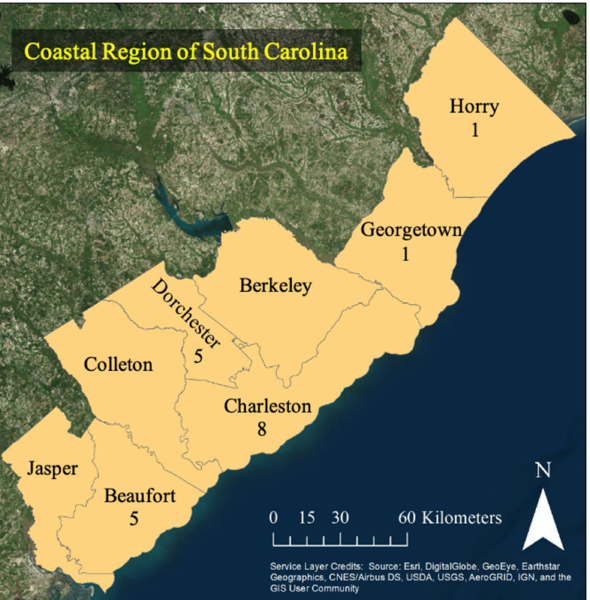
Figure 1. Vibriosis cases caused by bacteria Vibrio spp. in the coastal counties of South Carolina (USA) for 2018. Absence of number means no reported cases for the county